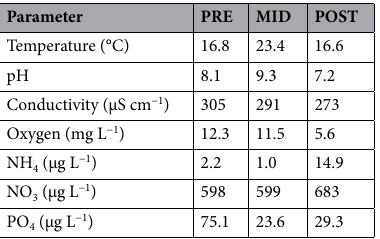
Table 1. Environmental parameters of surface water. PRE pre-summer period, MID mid-summer period, POST post-summer